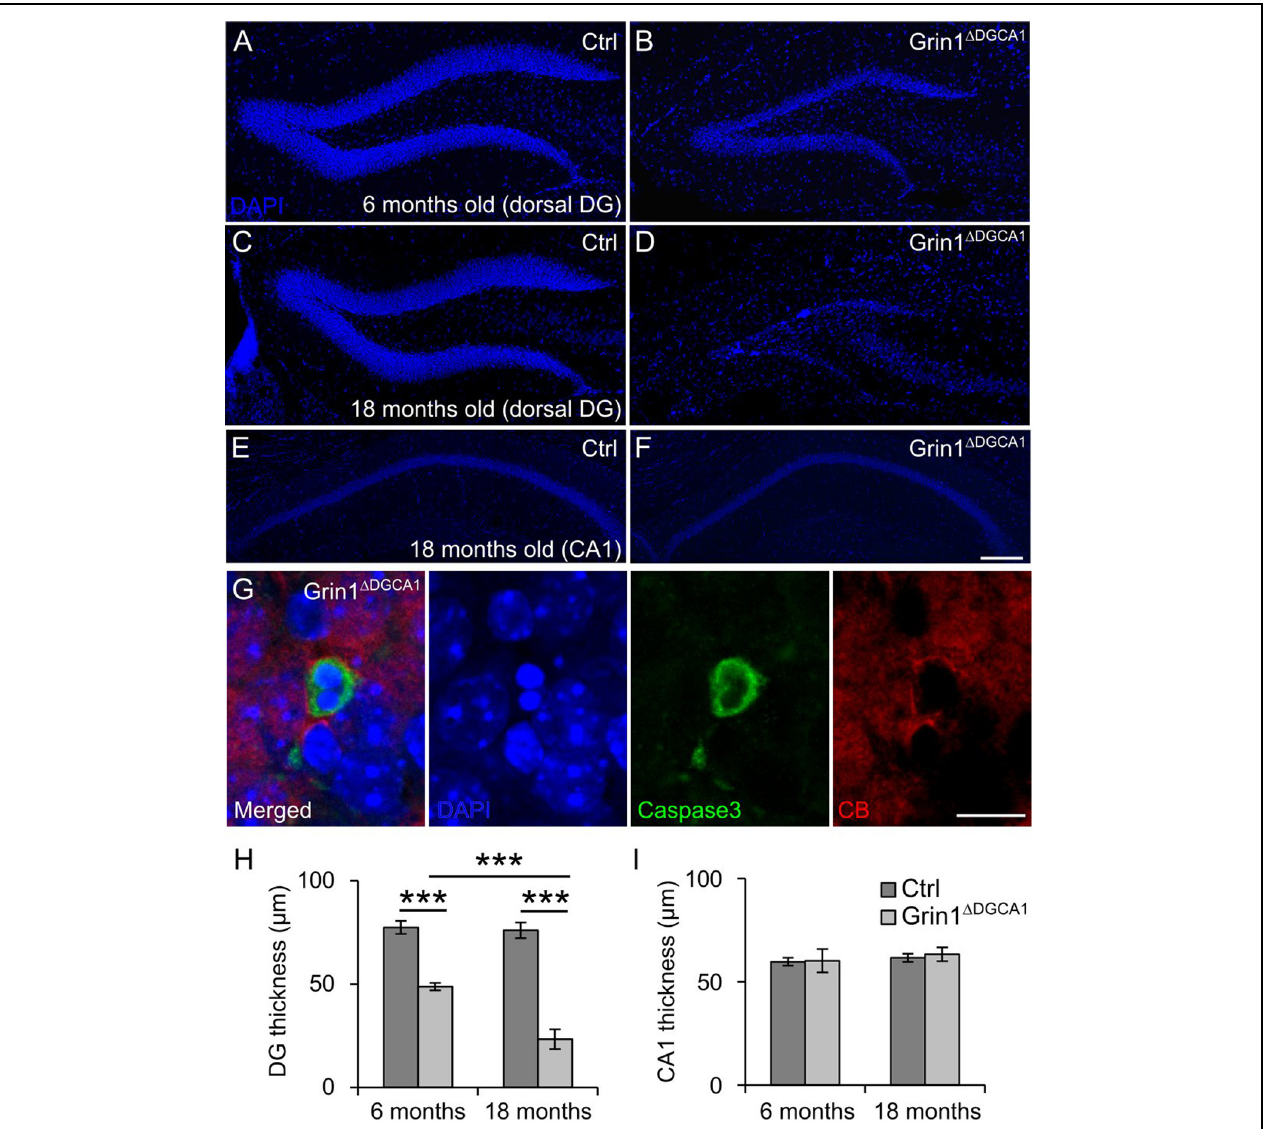
FIGURE 1 | GluN1 deletion causes age-dependent neurodegeneration in the dorsal dentate gyrus (DG). (A) DAPI staining illustrating a section of a dorsal DG from a 6 months old control (Ctrl) mouse. (B) DAPI staining of a dorsal DG from a 6 months old Grin1 (cid:2) DGCA 1 mouse. Note the thinning of the dentate granule cell layer. (C) DAPI staining illustrating a section of a dorsal DG from an 18 months old control mouse. (D) DAPI staining of a dorsal DG from an 18 months old Grin1 (cid:2) DGCA 1 mouse. Note the thinning of the dentate granule cell layer following profound neurodegeneration. (E) DAPI staining illustrating a section of a dorsal CA1 from an 18 months old control mouse. (F) DAPI staining of a dorsal DG from an 18 months old Grin1 (cid:2) DGCA 1 mouse. There is no difference between the two genotypes. (G) Representative image from the DG showing an apoptotic, i.e., caspase-3-positive, CB-positive neuron in a 6 months old Grin1 (cid:2) DGCA 1 mouse. The section is counterstained with DAPI. (H) Quantitative evaluation of dorsal DG thickness in 6 and 18 months old control and Grin1 (cid:2) DGCA 1 mice. The thickness of the DG was analyzed by two-factor ANOVA, followed by pairwise comparison test with p -value modification by Holm’s method, ∗∗∗ p < 0.0005. The DG is thinner in Grin1 (cid:2) DGCA 1 mice [ F (1,16) = 662.39, p < 0.0005], and the difference increases with aging [ F (1,16) = 59.92, p < 0.0005]. There is a significant interaction between genotype and age [ F (1,16) = 53.99, p < 0.005]. (I) Quantitative evaluation of CA1 thickness in the dorsal hippocampus in 6 and 18 months old control and Grin1 (cid:2) DGCA 1 mice. There is no difference in the thickness of the CA1 layer (two-factor ANOVA, no significant effect of genotype [ F (1,16) = 0.594], no significant effect of age [ F (1,16) = 2.793], and no significant interaction between age and genotype [ F (1,16) = 0.168]. Scale bars, in (F) , which applies to (A–E) , and (G) ,